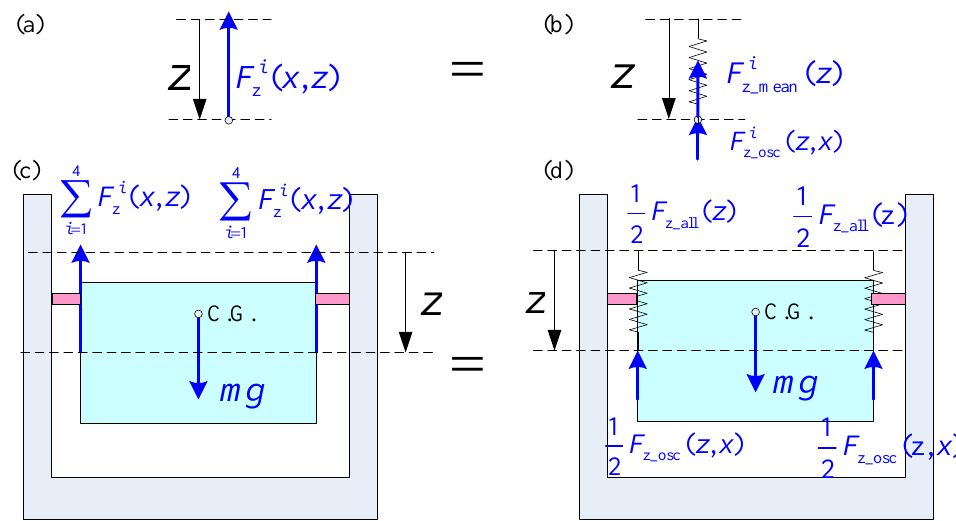
Figure 6. Decomposition of levitation force: ( a ) i -th levitation force F i z ( x , z ) ; ( b ) decomposition of i -th levitation force; ( c ) force diagram of vehicle with γ ( t ) = 0; ( d ) decomposition of force diagram of vehicle with γ ( t ) = 0.